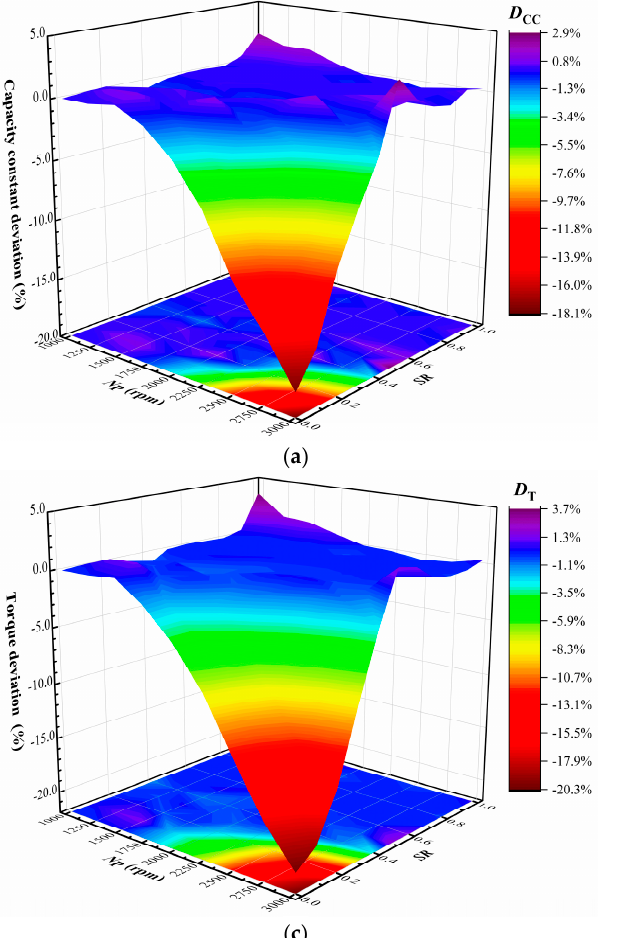
Figure 6. Influence of cavitation on hydraulic performance of torque converter under various N P and SR. ( a ) Capacity constant ( CC ). ( b ) Efficiency ( η ). ( c ) Torque of turbine ( T T ). ( d ) Torque of stator ( T S ).